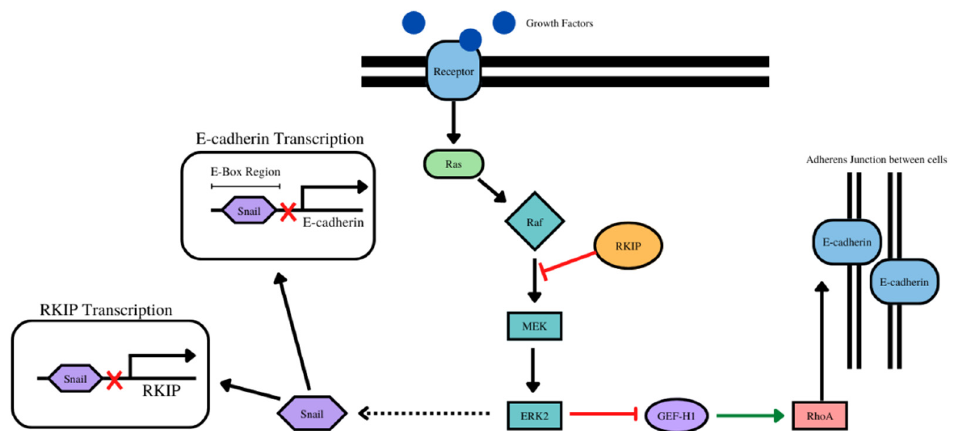
Figure 4. Crosstalk between RKIP and E-cadherin. RKIP inhibits the MEK/ERK signaling pathway by interrupting the interaction between Raf and MEK, stopping the progression of the signal through the pathway. Erk 2 is an inhibitor of GEF-H1, an activator of RhoA which helps in the stabilization of E-cadherin at adherens junctions. ERK signaling increases Snail production which inhibits the transcription of both RKIP and E-cadherin.